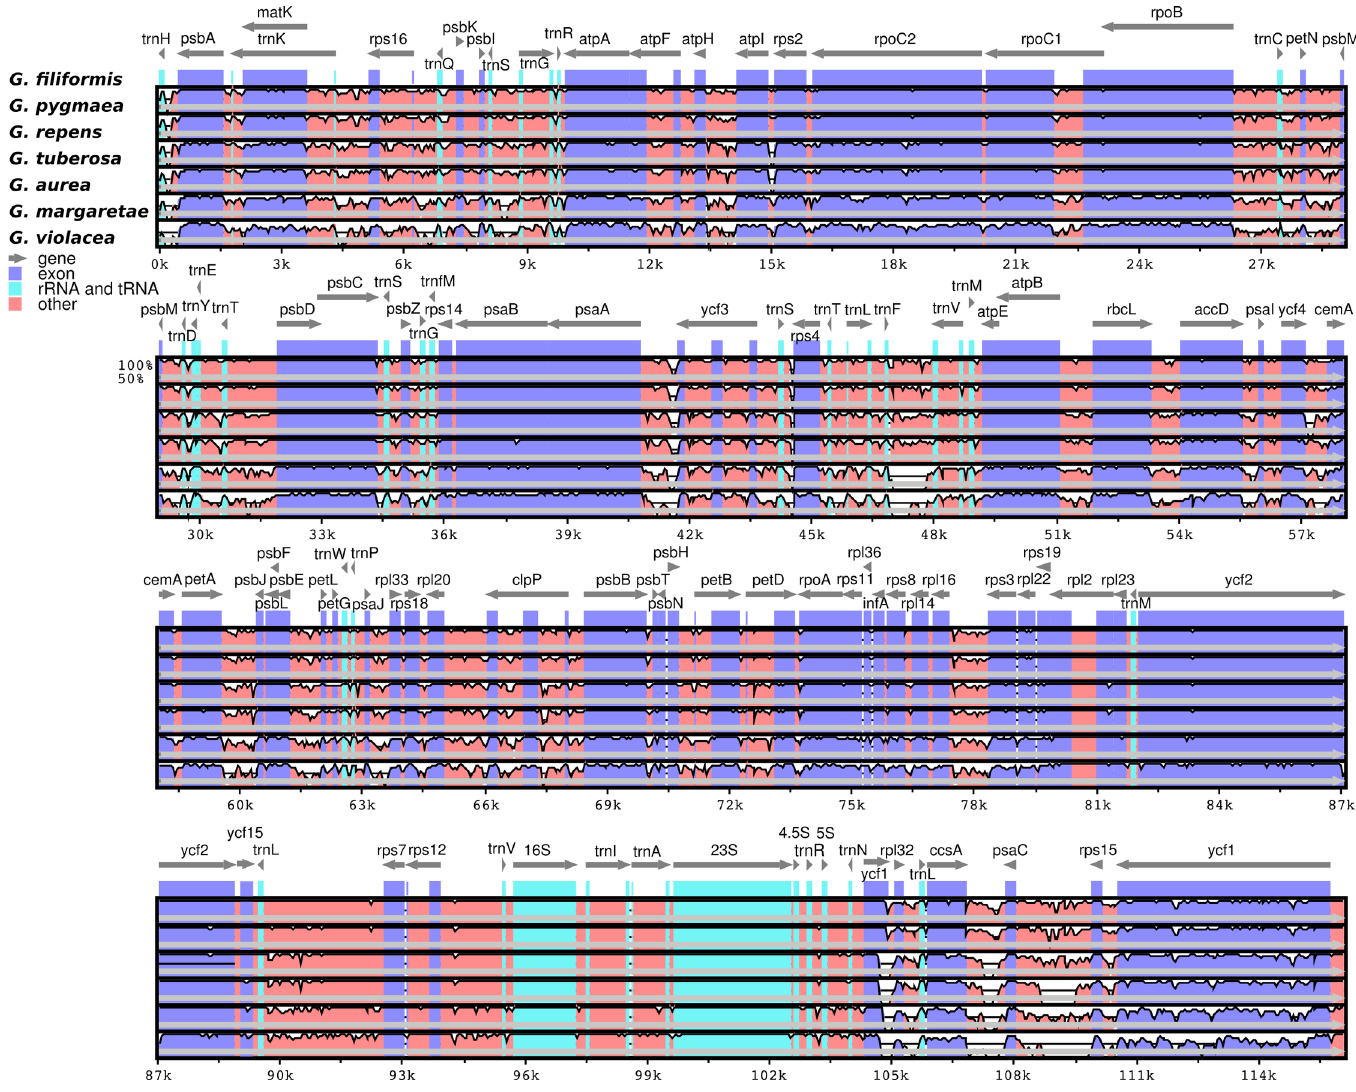
Fig 3. Sequence identity plots for the six assembled Genlisea species and previously published G . margaretae